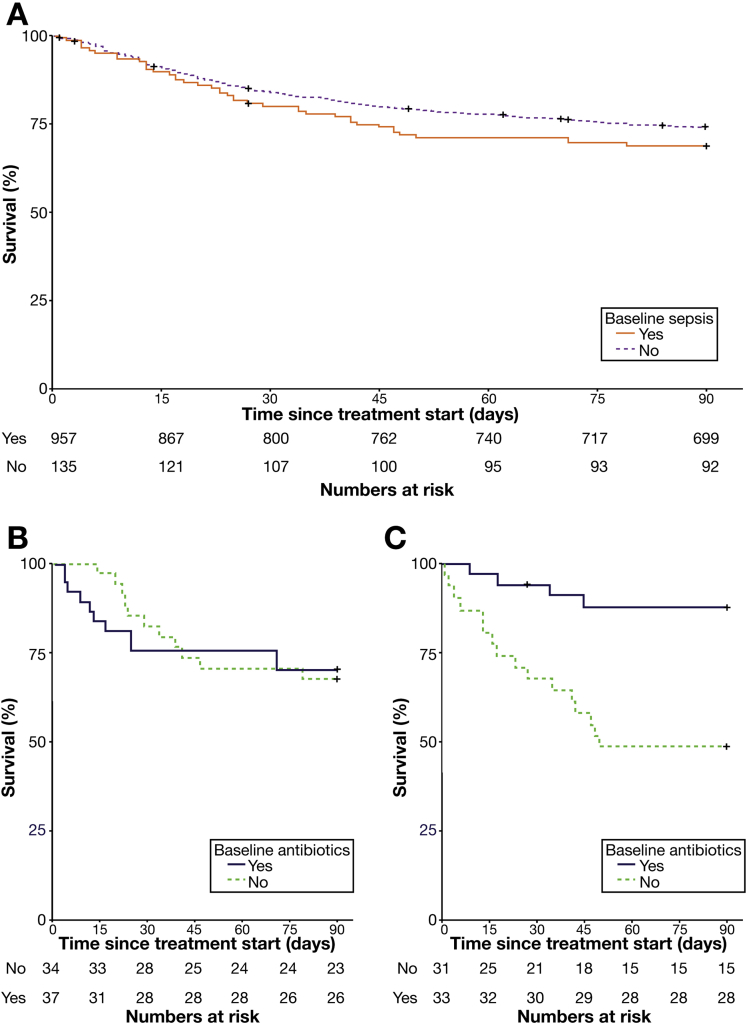
Prescription of antibiotics significantly modulates the impact of baseline infection on 90-day mortality in prednisolone-treated patients. In all patients, no statistically significant impact of baseline sepsis on mortality is seen (A). In patients who present with infection and do not receive prednisolone, continuation of antibiotics alongside treatment for AH does not impact upon mortality (B), however, in patients who receive prednisolone concurrent antibiotic therapy significantly reduces mortality (C).